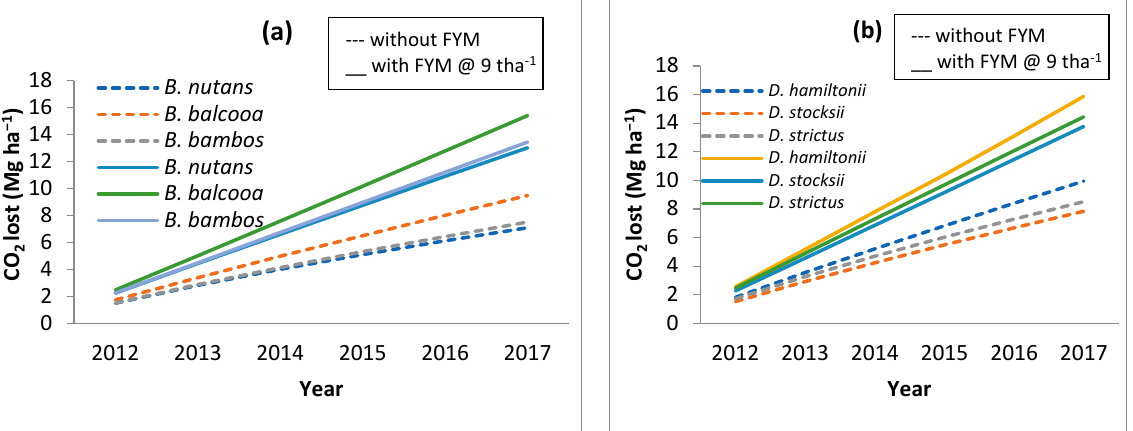
Figure 6. CO 2 evolved as a result of addition of FYM @ 9 t ha − 1 in ( a ) Bambusa species and ( b ) Den- drocalamus species.